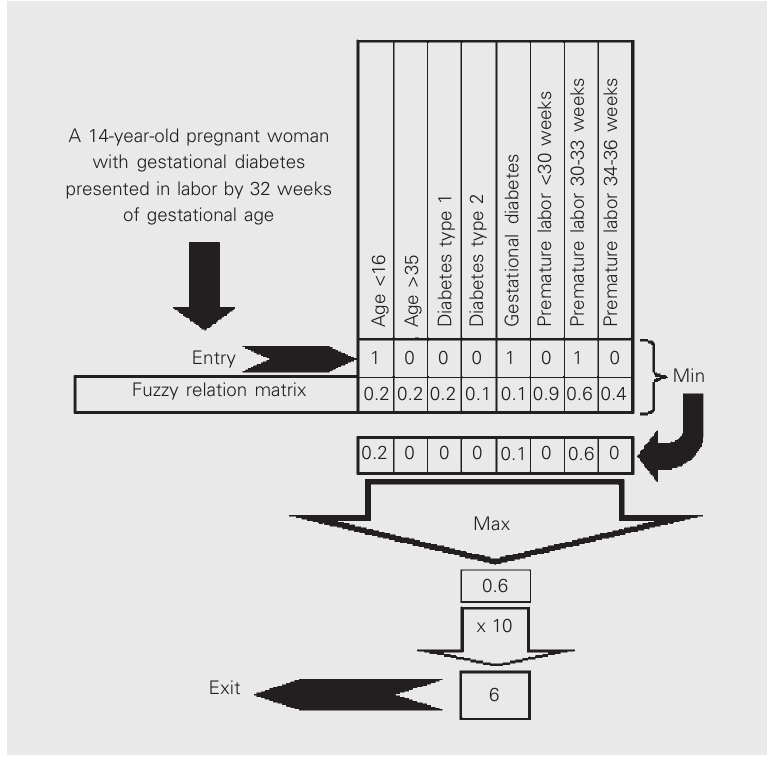
Figure 1. Example of fuzzy maximum-minimum (max-min) composition performance. A hypothetical clinical example shows the rationale of the model, using a small part of the knowledge bank for